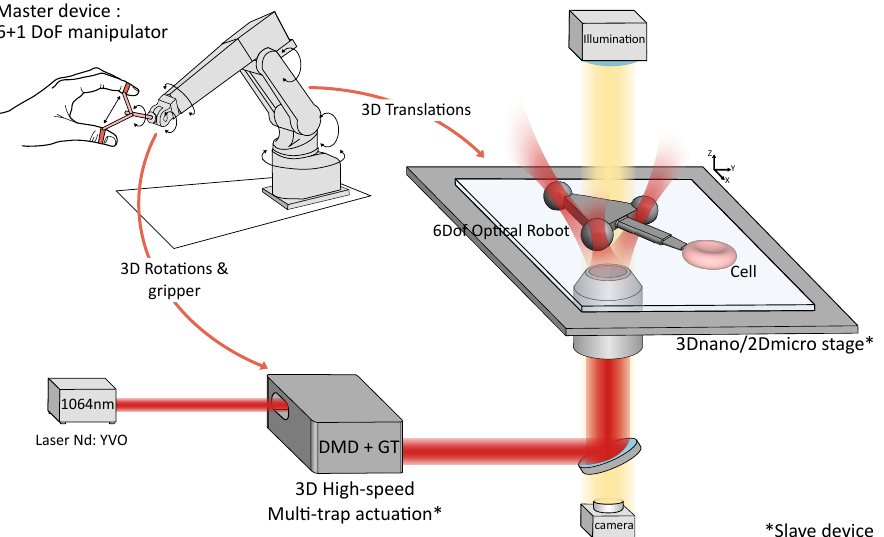
Figure 1. Optical-micromanipulation platform for dexterous single-cell